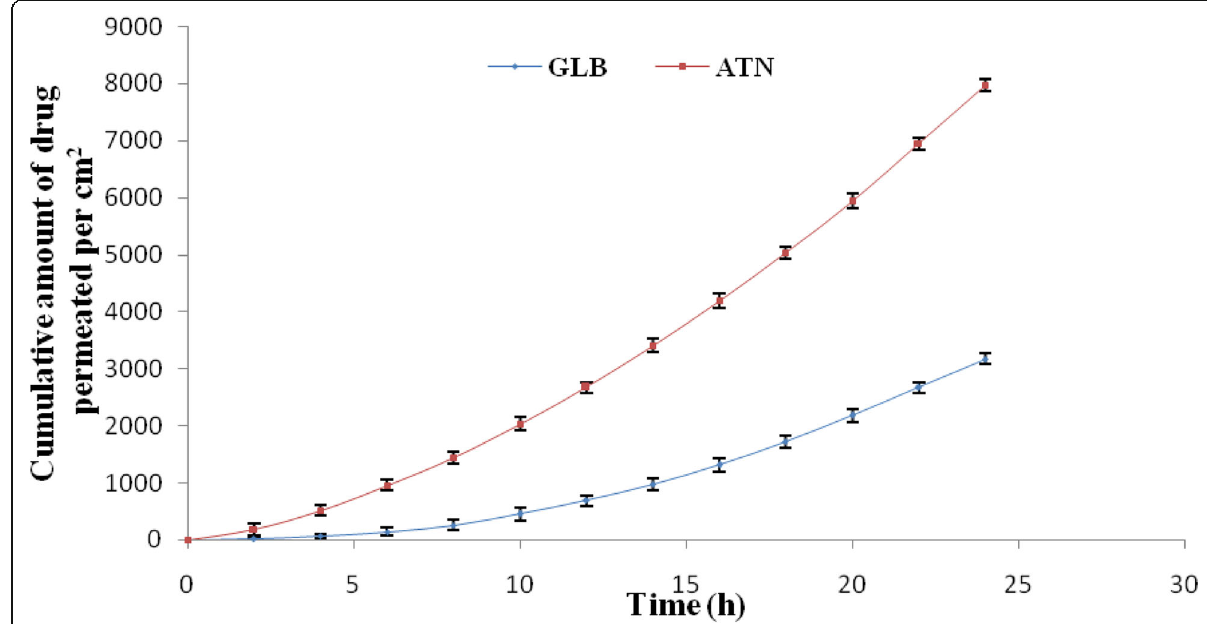
Fig. 8 Ex vivo skin permeation profile of OCNIG